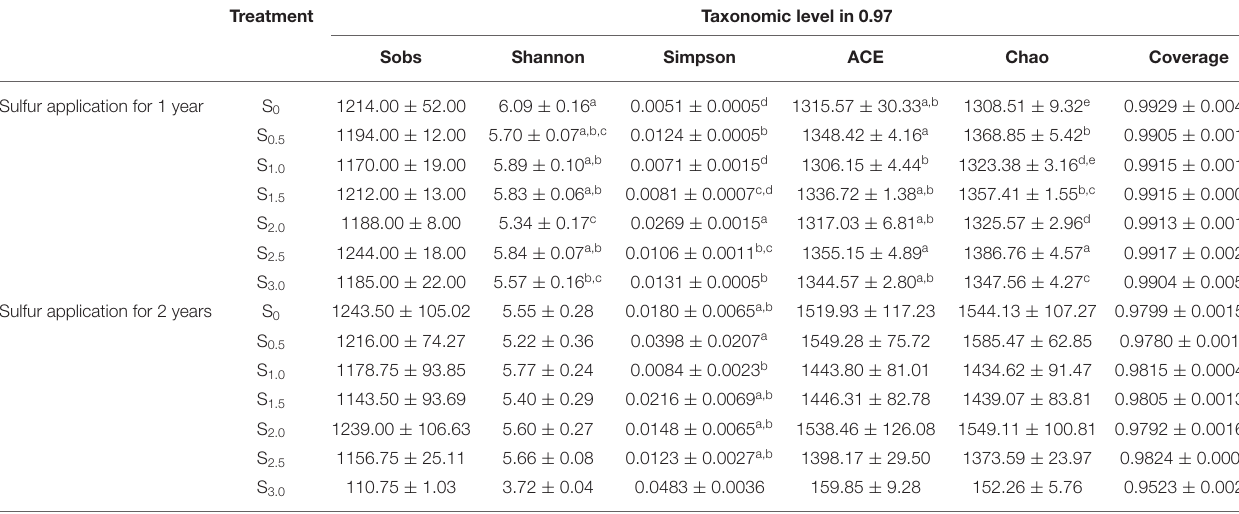
TABLE 2 | Sequence statistics and diversity indexes of sulfur on kiwifruit rhizosphere soil bacteria.